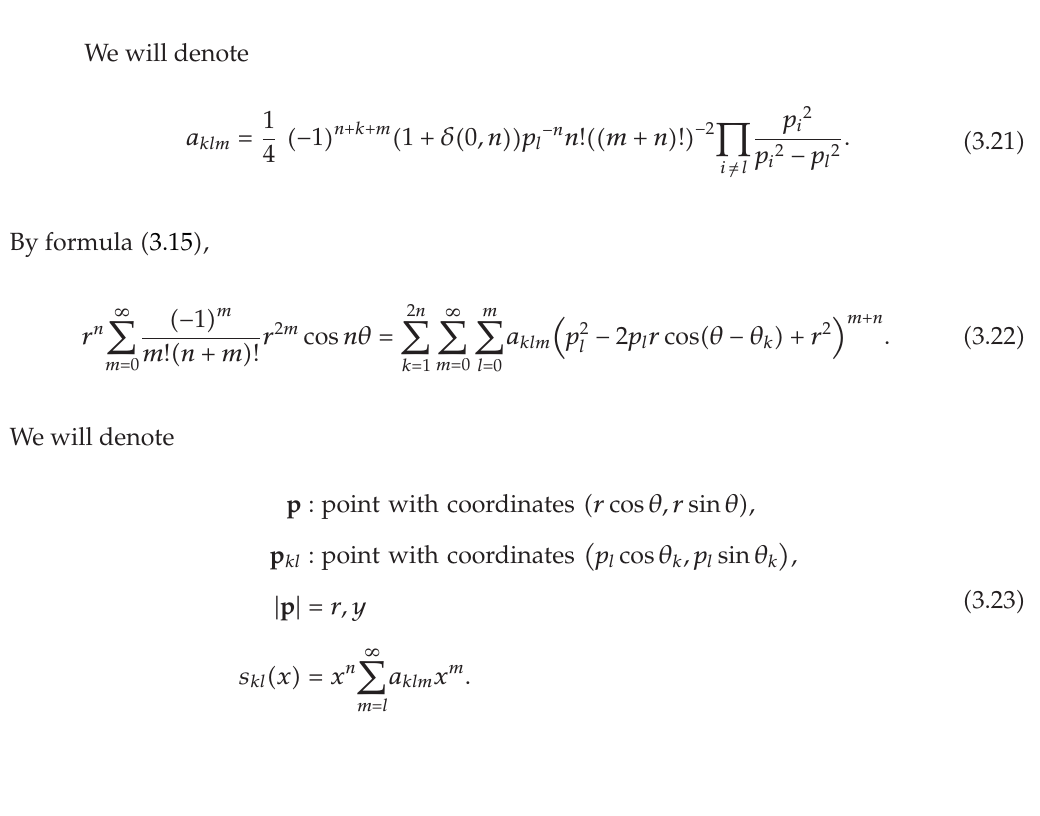
Figure 6: Graphics of both sides of formula (cid:4) 3.22 (cid:5) , n (cid:7) 2 , 3. In the series on the right, we add up to m (cid:7) 6.